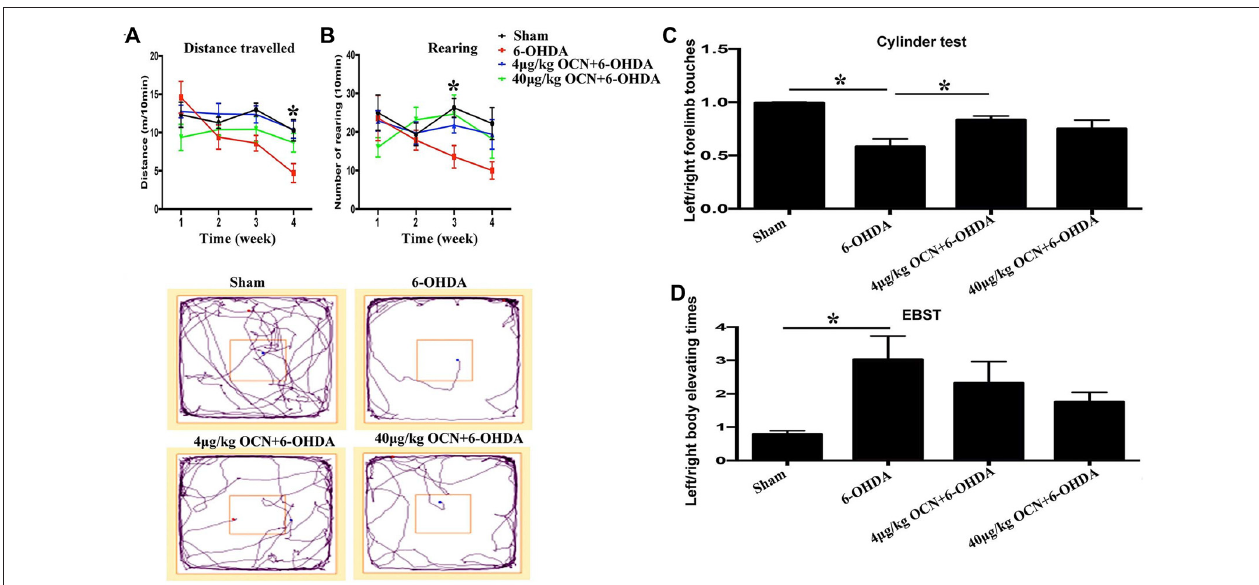
FIGURE 2 | Effect of intraperitoneal (i.p.) injection of OCN on distance traveled (A) and rearing responses (B) in the open-field test (OFT). The cylinder test (C) and elevated body swing test (EBST; D ) were used to evaluate locomotor asymmetry. Compared with the sham groups, 6-OHDA injection decreased the distance traveled by rats in the OFT, and reduced the use of contralateral (left) forelimb in the cylinder test. The injection of 4 µ g/kg OCN significantly improved the movement distance of 6-OHDA-lesioned rats in the 4th week ( P < 0.001), while 40 µ g/kg OCN increased the number of rearing responses in the 3rd week ( P < 0.05). The representative traces of the OFT are shown in the lower panel of (A,B) . In the cylinder test, 4 µ g/kg OCN improved the use of the contralateral forelimb ( P < 0.05). No obvious differences were observed in the EBST. n = 8–10, ∗ P < 0.05 (compared with the 6-OHDA